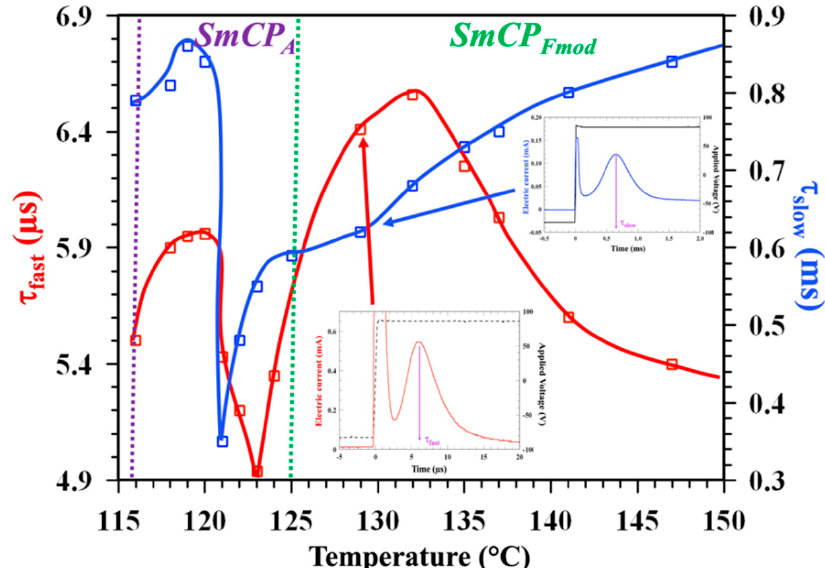
Figure 4. Temperature dependences of the slow (blue square and line) and fast (red squares and line) switching times corresponding to the positions of the slow (blue) and fast (red) peaks appear under rectangular voltages with ± 84 V amplitudes, f = 20 kHz for detection of fast peak and f = 400 Hz for detection of slow peak, as shown in the insets. The errors are ± 0.5 µs and ± 0.02 ms for the fast and slow switching time measurements, respectively.